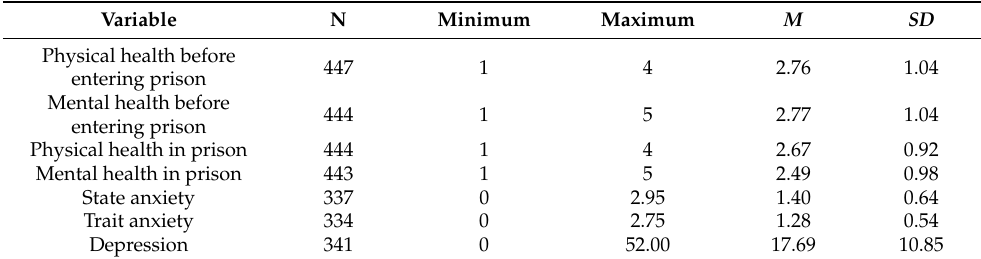
Table 5. Descriptive statistics of the observed variables.